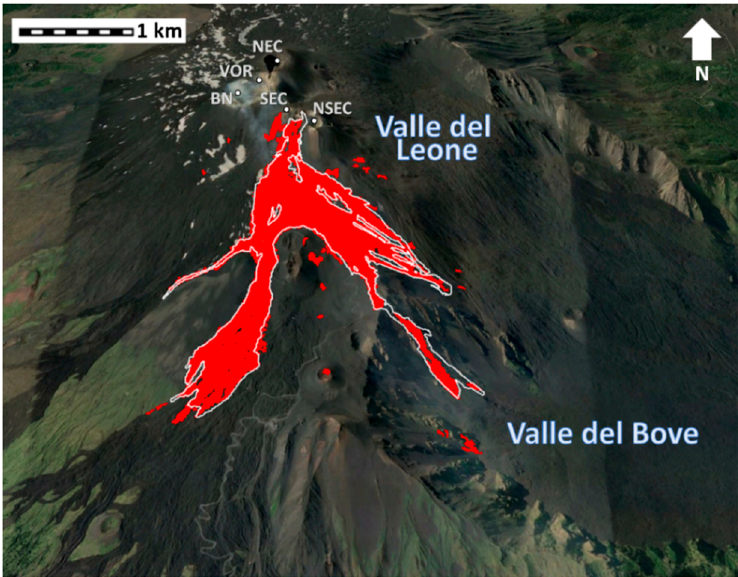
Figure 5. Lava flow map resulting from the BNN and the post-processing stages (red) and the contour of the real lava flow (white) observed during the 2017 Etna eruption.